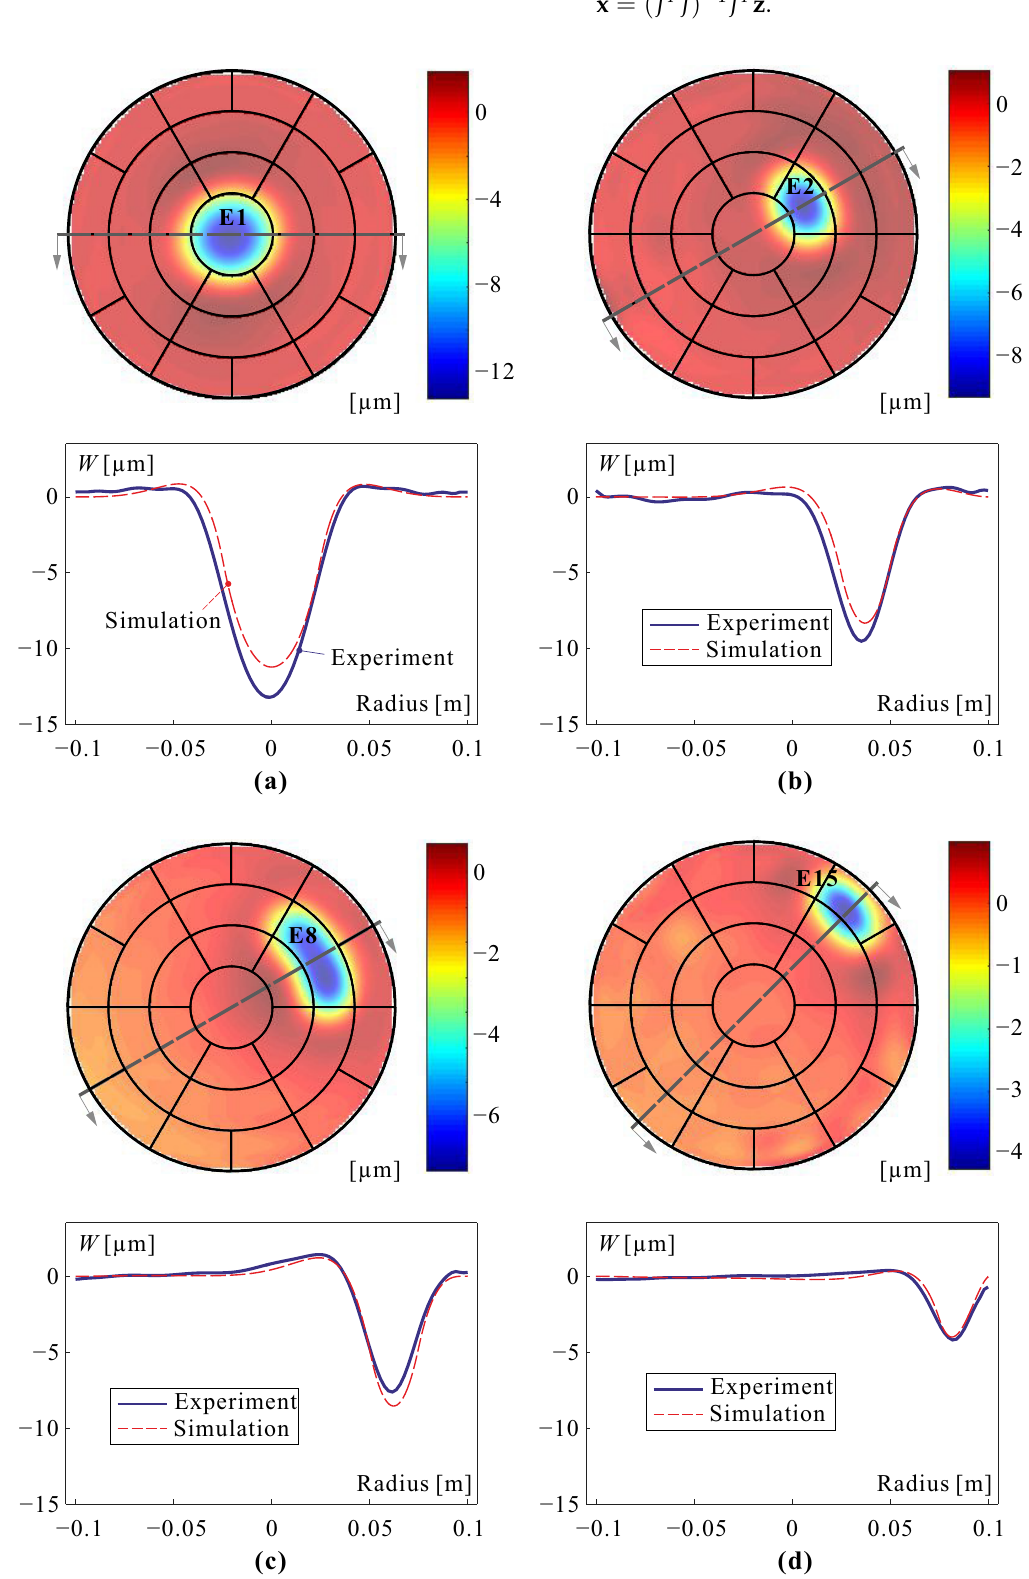
Figure 5. Experimental influence functions of electrodes E 1 , E 2 , E 8 and E 15 for a voltage normalized to 100 V and cross section at 45 ◦ of the reflector